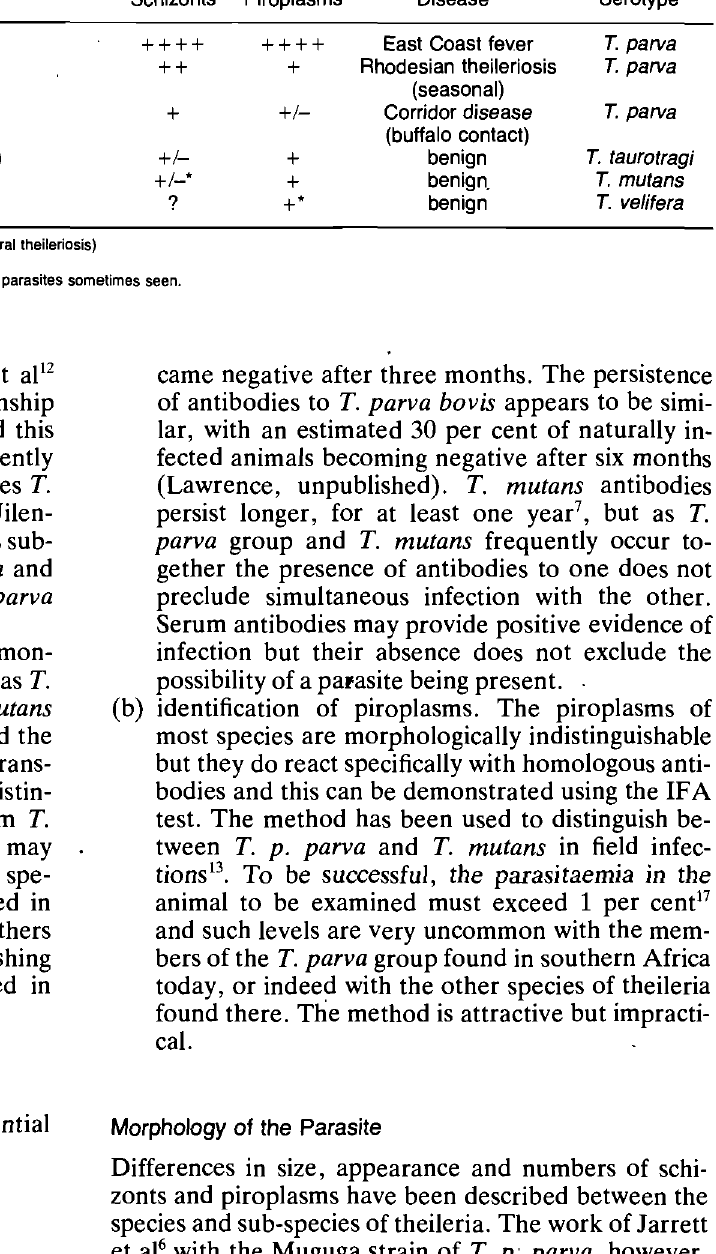
Table 1; DIFFERENTIAL DIAGNOSTIC FEATURES OF BOVINE THEILERIAS OF SOUTHERN AFRICA Species